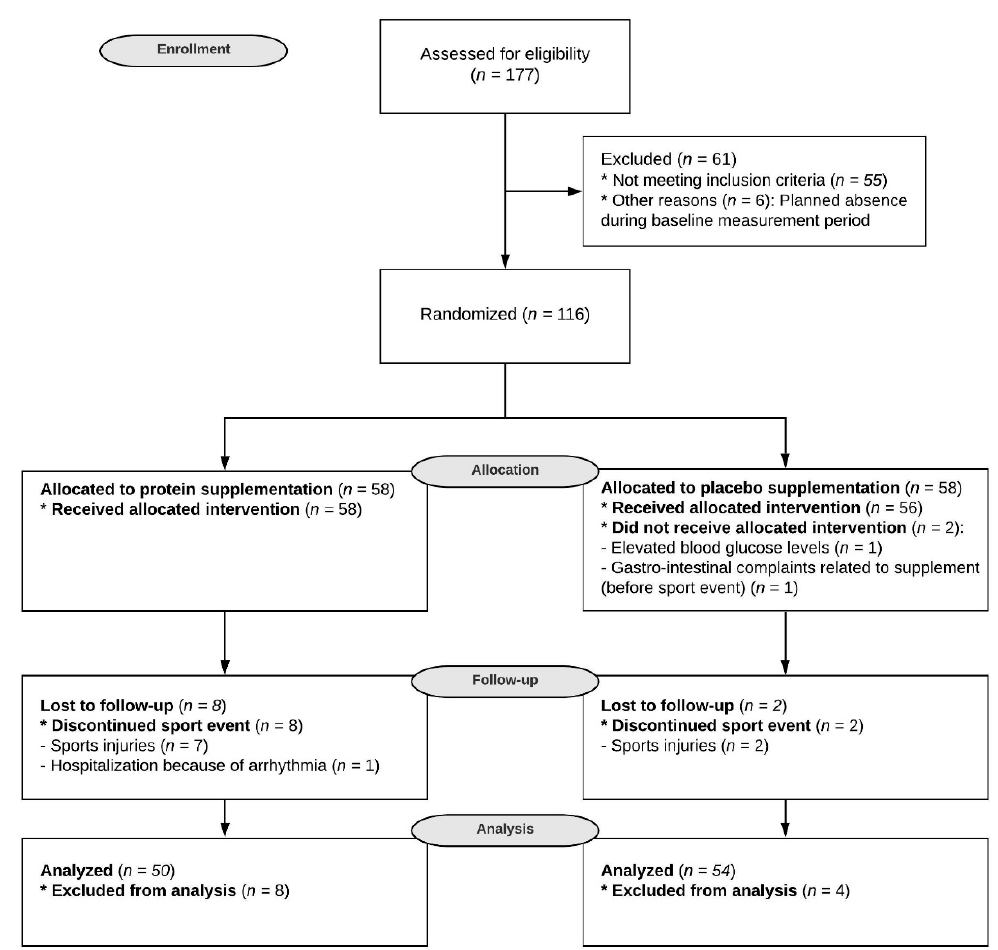
Figure 1. CONSORT flow diagram. This flow diagram illustrates the movement of participants through the study, which was conducted between March 2017 and July 2017. CONSORT: CONsolidated Standards Of Reporting Trials.